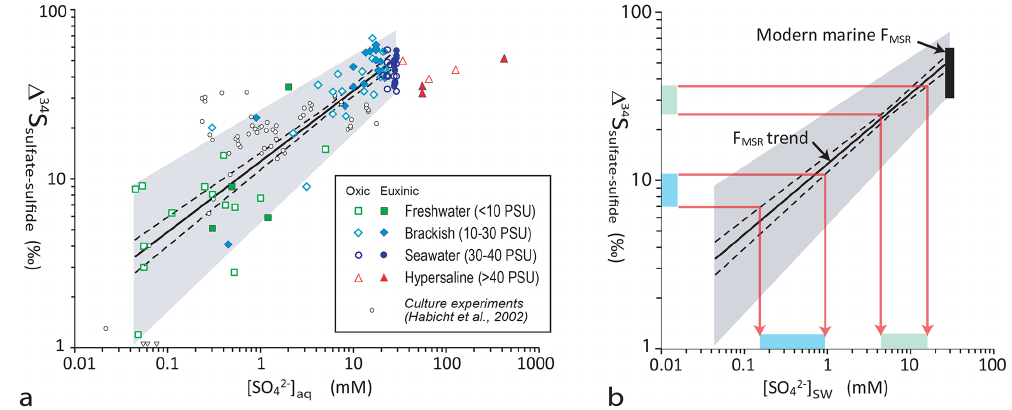
Figure 2. The MSR-trend method. (a) Data from 81 modern aqueous systems (Table S1). The non-hypersaline environments ( n = 75) yield a linear regression (solid line; y = 0.42 x + 1.10 in log units) with r = + 0 . 90 t statistic = 1.99, ( p(α ) < 0.01) and a limited uncertainty range (dashed lines). The MSR trend thus represents a process with an order of reaction ( n ) of 0.42 and a rate constant ( k ) of 1.10 (cf. Jones et al., 2007). The gray field encloses most of the data from Table S1 and highlights the overall trend. Analysis of the data set by redox environment yielded statistically indistinguishable trends for oxic ( y = 0.48 x + 1.10; r = + 0 . 88, n = 44, p(α ) < 0.01) and euxinic settings ( y = 0.40 x + 1.06; r = + 0 . 89, n = 31, p(α ) < 0.01). The Habicht et al. (2002) data set of 60 sulfate-reducing microbial (SRM) culture values is shown for comparison; these data have been converted to log–log format, and data points that are off-scale (i.e., (cid:49) 34 S sulfate-sulfide < 1‰) are shown by triangles on the abscissa. Neither the six hypersaline environments in our data set (red symbols) nor the Habicht et al. data (small open circles) were included in the regression analysis. (b) Use of the MSR trend to estimate paleo-seawater [SO 2 − ] aq . Measured 4 values of (cid:49) 34 S sulfate-sulfide are projected from the ordinal scale to the MSR trend and then to the abscissa. Note that uncertainty in the slope of the MSR trend is accommodated by projection to the upper uncertainty limit for (cid:49) 34 S sulfate-sulfide maxima and to the lower uncertainty limit for (cid:49) 34 S sulfate-sulfide minima. The vertical black bar at [SO 2 − ] aq = 1.45 (i.e., the modern seawater sulfate concentration of 29mM) 4 represents the range of F MSR variation among modern marine SRM